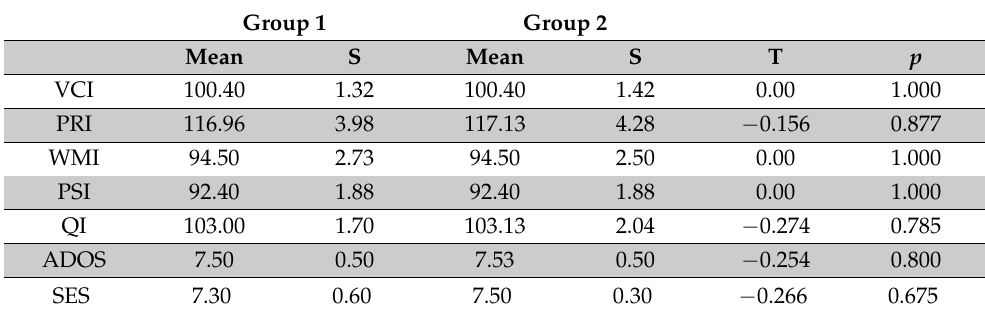
Table 1. Statistical data of the inclusion